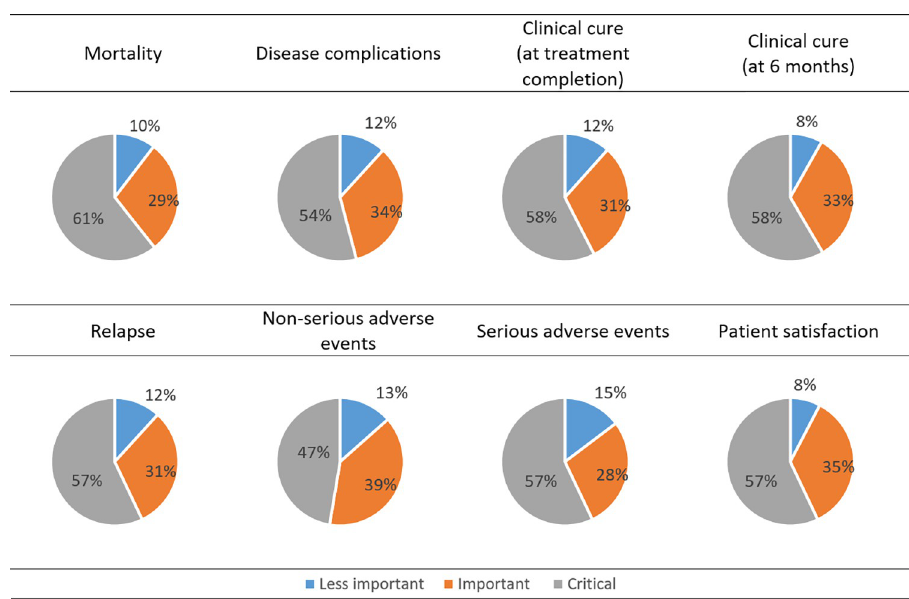
Fig 2. Valuation of each of the outcomes of